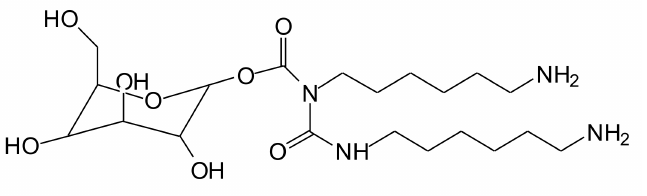
Figure 5. Example of alternative, possible glucose diurethane structures.